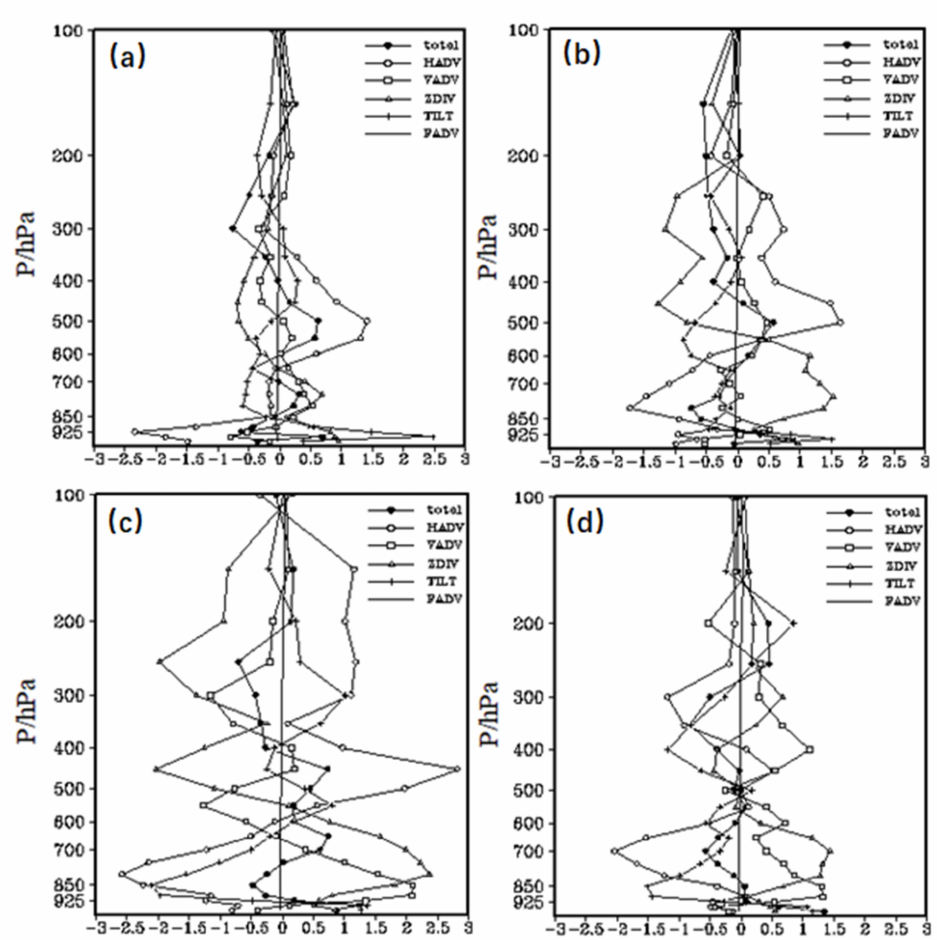
Figure 10. Simulated vertical distribution of each term of vorticity equation (unit: 10 − 8 s − 2 ) averaged in the region (29–31 ◦ N, 121–124 ◦ E) on 4–5 August 2020. ( a ) 20:00 BT 4, ( b ) 02:00 BT 5, ( c ) 05:00 BT 5, ( d ) 08:00 BT